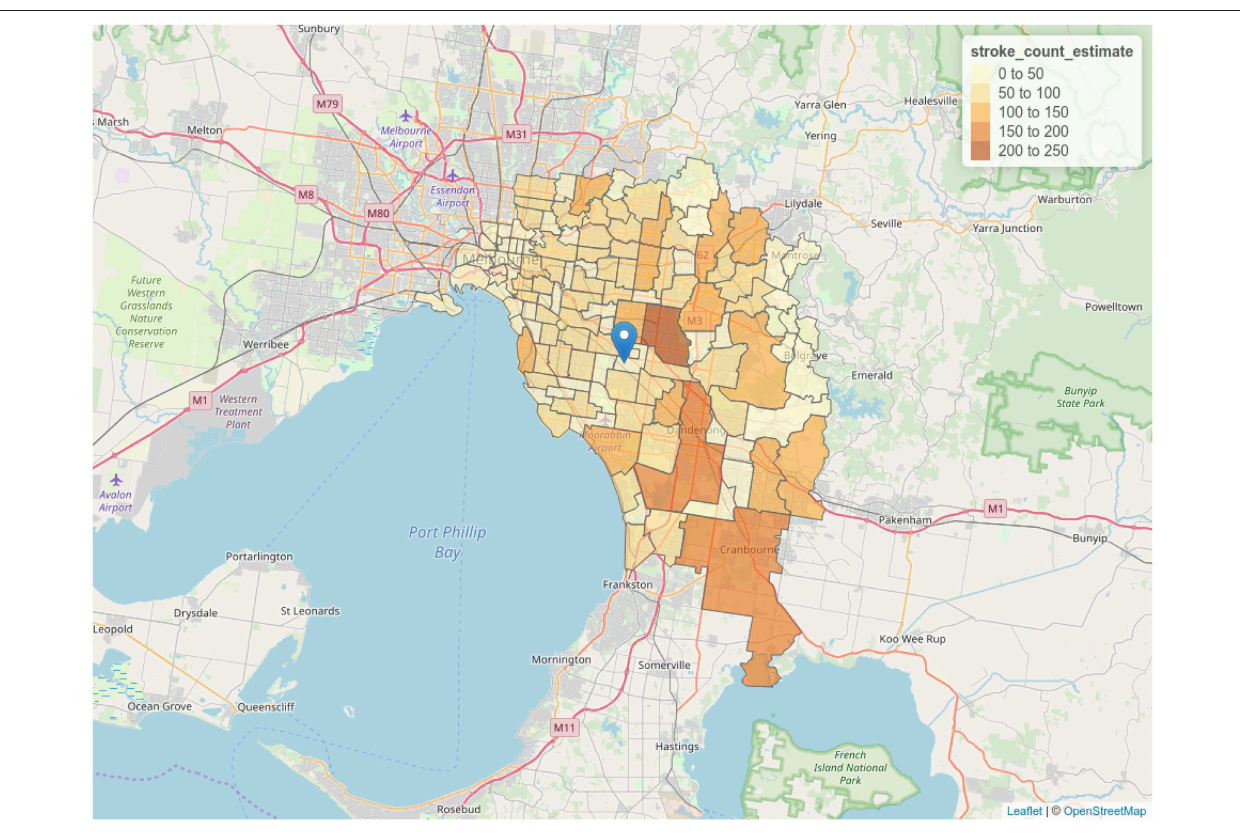
Frontiers in Neurology |